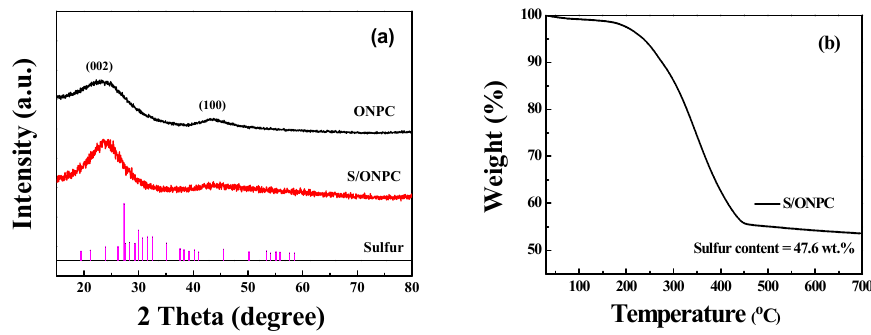
Figure 3. XRD patterns of the ONPC and the S/ONPC composite ( a ); Thermogravimetric (TG) curve of the S/ONPC composite ( b ).